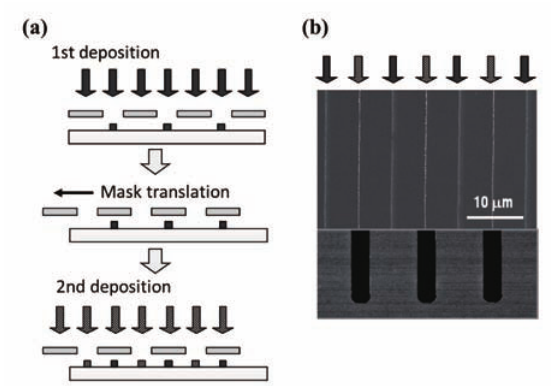
Fig. 6 Sequential operation of the ion-induced focusing mask. (a) A schematic illustration of the sequen- tial patterning by translating the focusing mask. (b) A SEM image of line arrays of 20-nm silver nanoparticles after two sequential deposition. (a) and (b) are reprinted with permission from ref 89. Copyright 2010